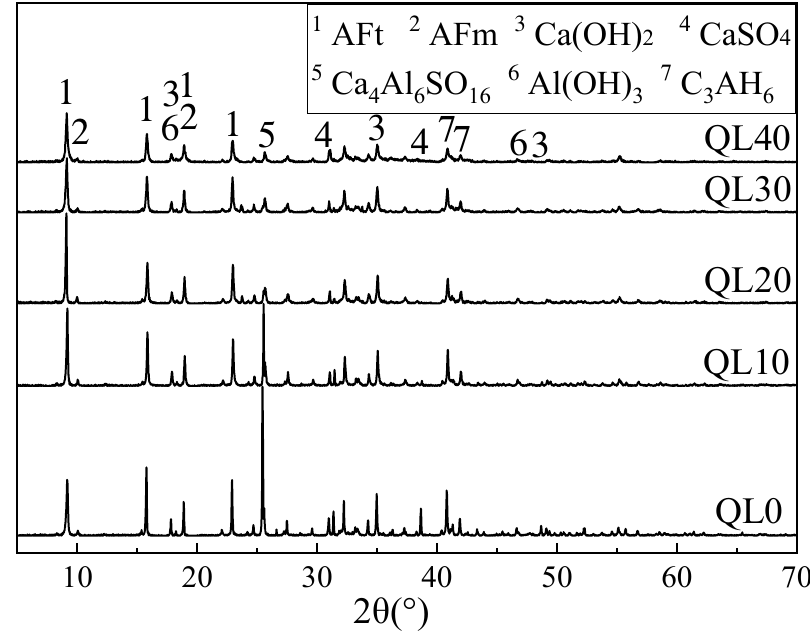
Figure 12. XRD patterns of the double liquid grouting materials with different quicklime contents at 28